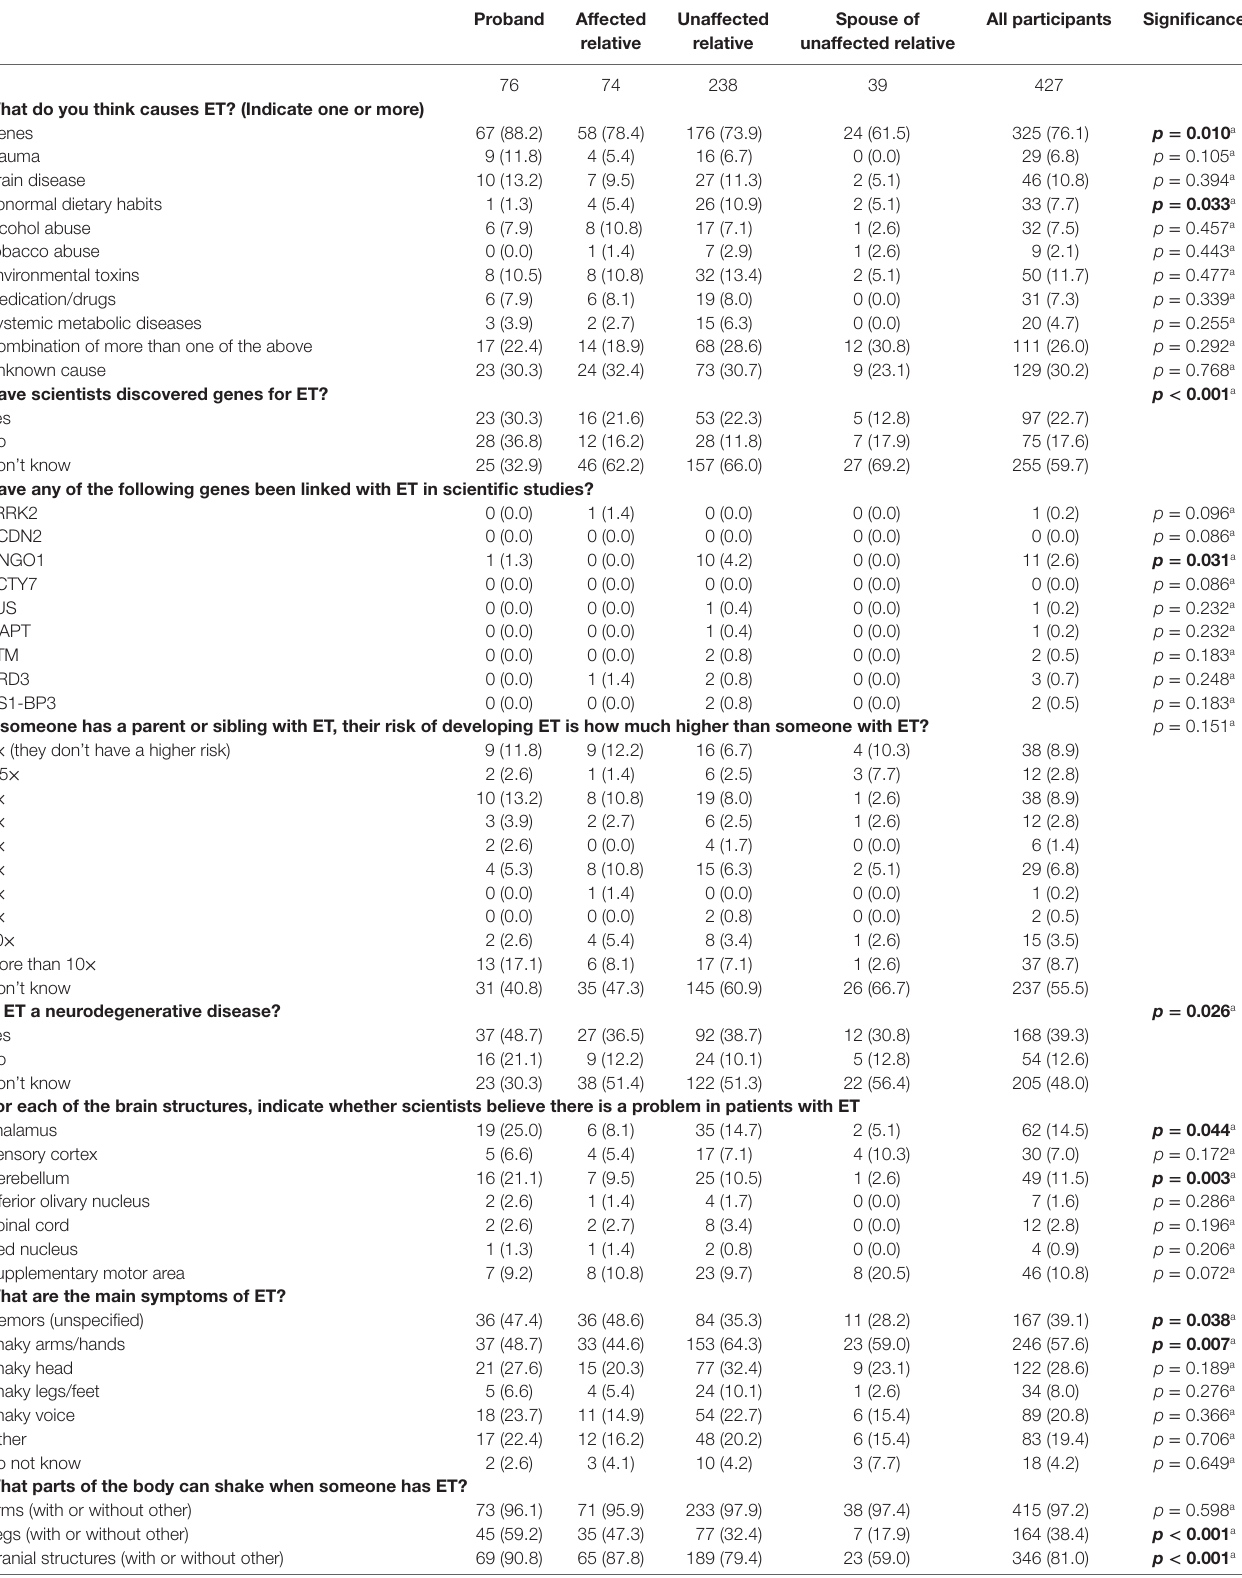
TaBle 2 | Responses of 427 participants to 28 questions about the essential tremor